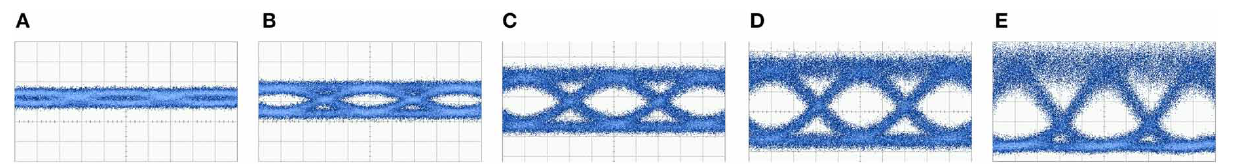
Figure 9 , and operating point was set at D ( ML = 7dB) in Figure 1 . (A) BR dependence. (B) V pp dependence. (C) V DC